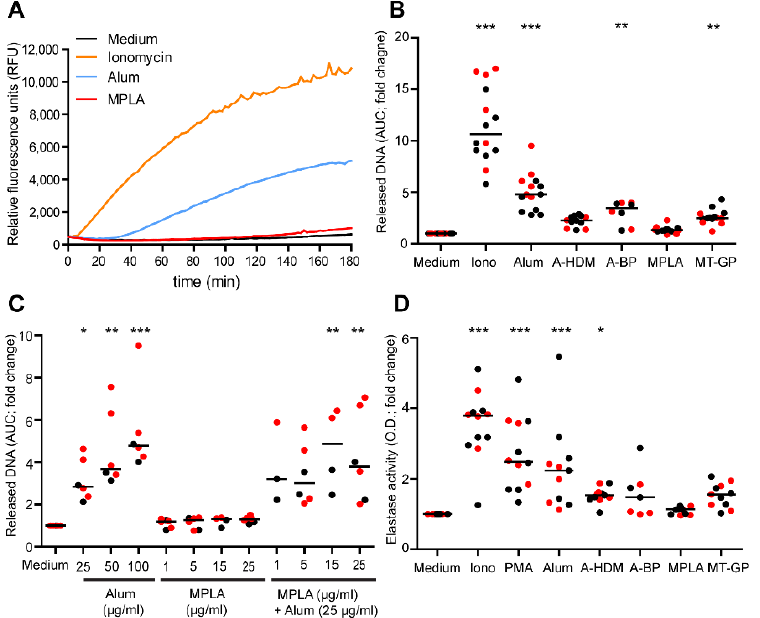
Figure 3. Quantification of NET release. Human neutrophils were primed with 25 ng/mL GM-CSF and incubated for 3 h with medium, ionomycin (Iono; 5 μ M), alum (100 μ g/mL), A-HDM (100 μ g alum/mL), A-BP (100 μ g alum/mL), MPLA (5 μ g/mL) and MT-GP (2.25 μ g MPLA/mL). The kinetics Sytox orange in plate reader assays. ( A ) One representative experiment and ( B ) cumulated data of 14 independent experiments using neutrophils from different donors. ( C ) Co-stimulation of neutrophils with MPLA and alum in 5 independent experiments with different donors. ( D ) Neutrophil elastase